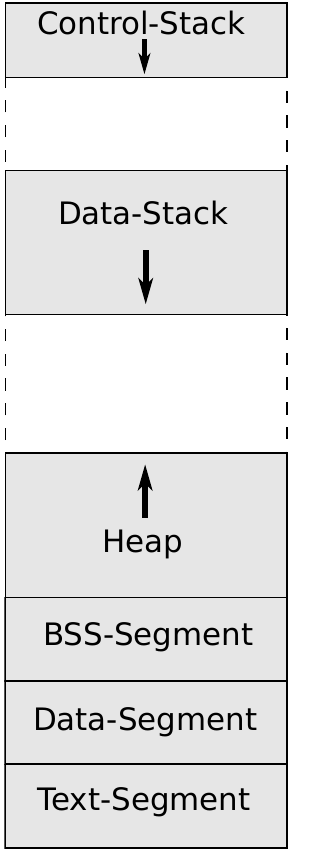
Figure 1. Userland memory layout of a program compiled with